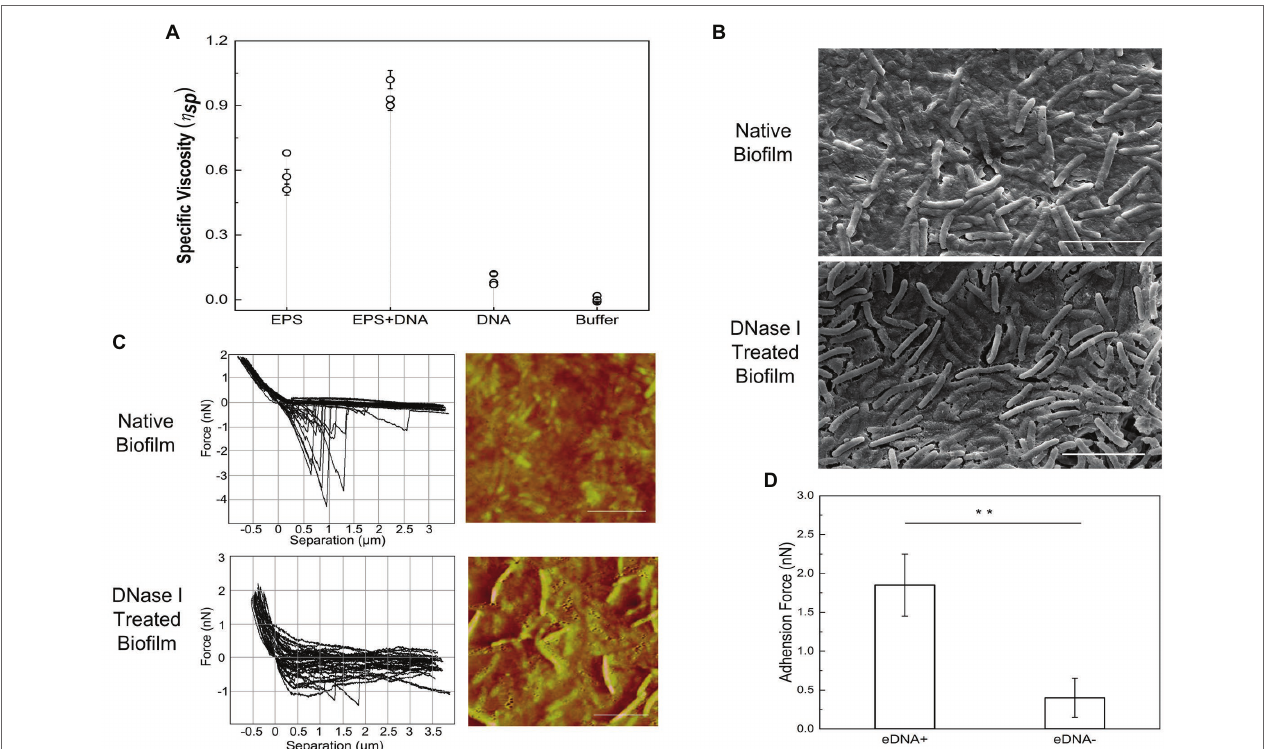
FIGURE 8 | Nanomechanical strength of DNA-EPS complex. (A) Specific viscosity of DNA, exopolysaccharides (EPS) and DNA-EPS complex. (B) SEM images of native (upper panel) or DNase I treated (lower panel) Myxococcus xanthus DK1622 biofilms. Scale bars represent 5 μ m. (C) Representative force curves and atomic force microscopy (AFM) images of native (upper panel) or DNase I treated (lower panel) Myxococcus xanthus DK1622 biofilms. Scale bars represent 5 μ m. (D) The average adhesion force between extracellular matrix (ECM) with (+) or without ( − ) eDNA and the tip of AFM cantilever. ** p <